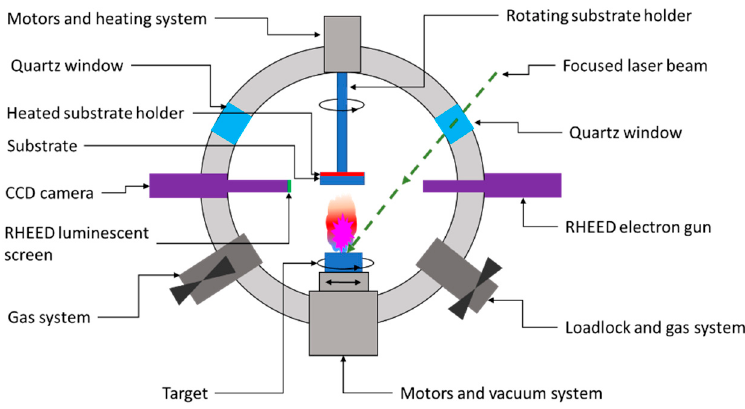
Figure 7. Schematic representation of a PLD deposition chamber.